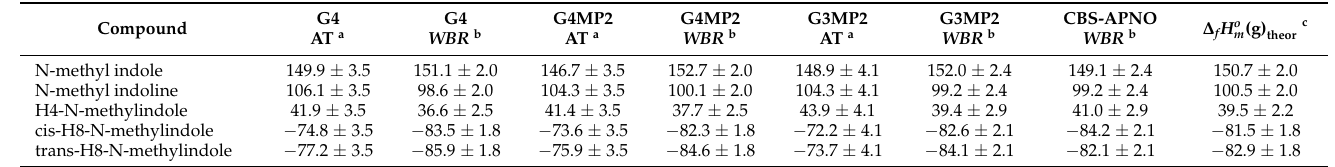
Table 6. Theoretical gas-phase enthalpies of formation ∆ f H o m (g) at T = 298.15 K ( p ◦ = 0.1 MPa) for indole derivatives as calculated by different methods (in kJ · mol − 1 ).